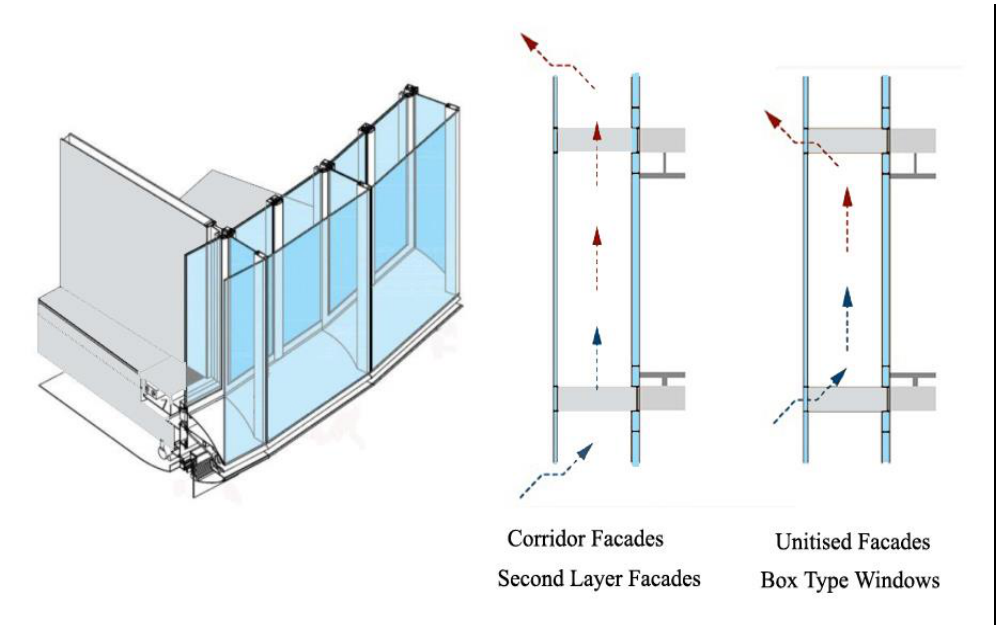
Buildings 2019 , 9 , x FOR PEER REVIEW Figure 10. Natural ventilation of double skin facades (figure by authors). Figure 10. Natural ventilation of double skin facades (figure by authors).